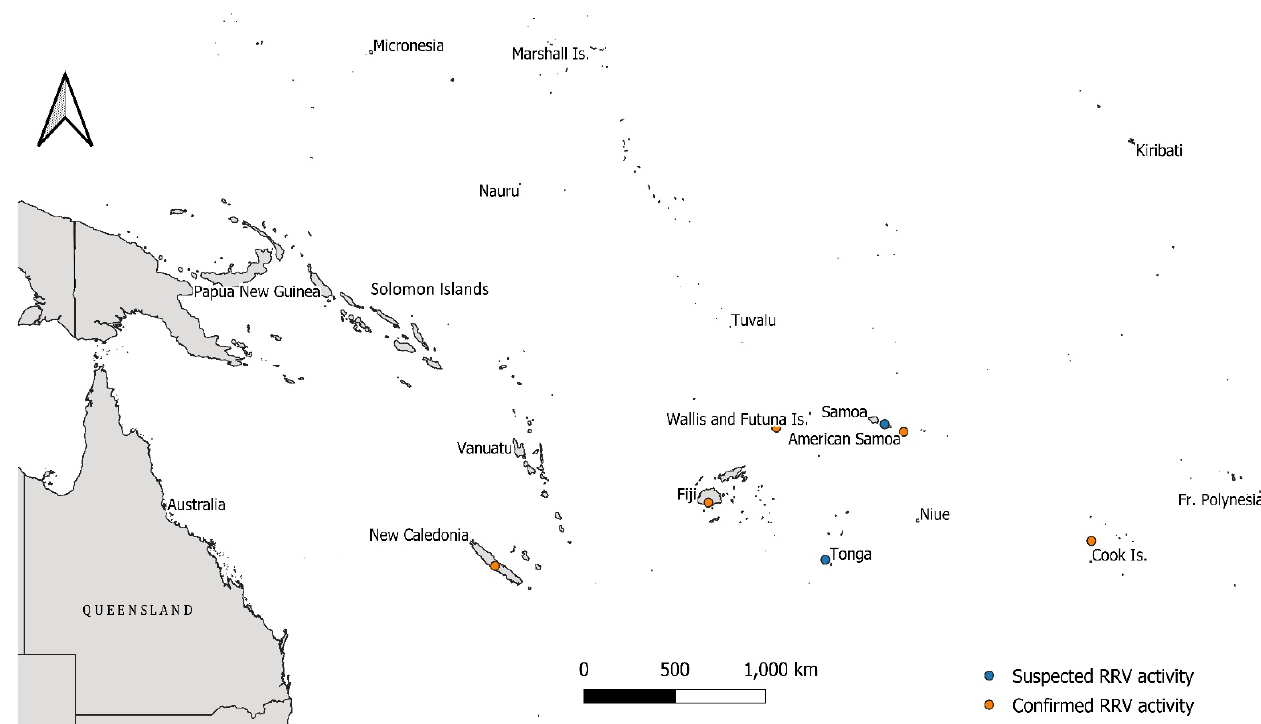
Figure 2. Map of the Pacific region and the location of Pacific Island Countries and Territories (PICTs) involved, or neighbouring, the explosive Ross River virus (RRV) epidemic that occurred between 1979 and 1980. Orange dots highlight PICTs where confirmed RRV activity with virus isolations was documented, while blue dots highlight locations where RRV activity was suspected during the outbreak. The proximity of Papua New Guinea to these areas of activity is of note. The scale bar is shown in the lower-centre of the map.